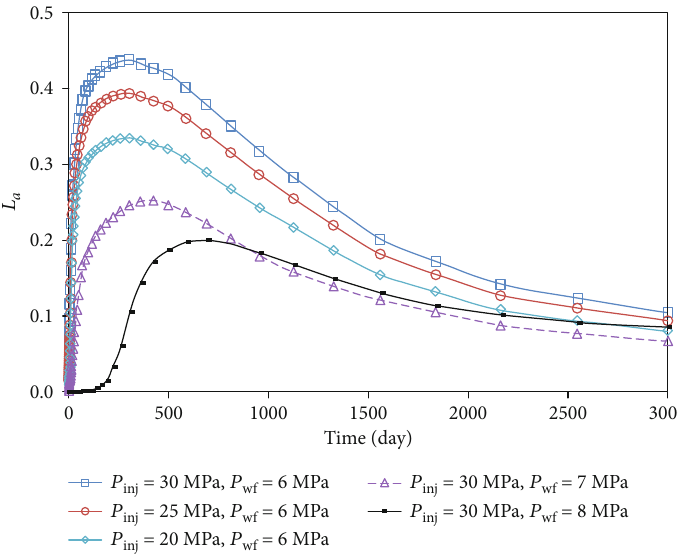
Figure 16: E ff ect of production pressure di ff erence on L